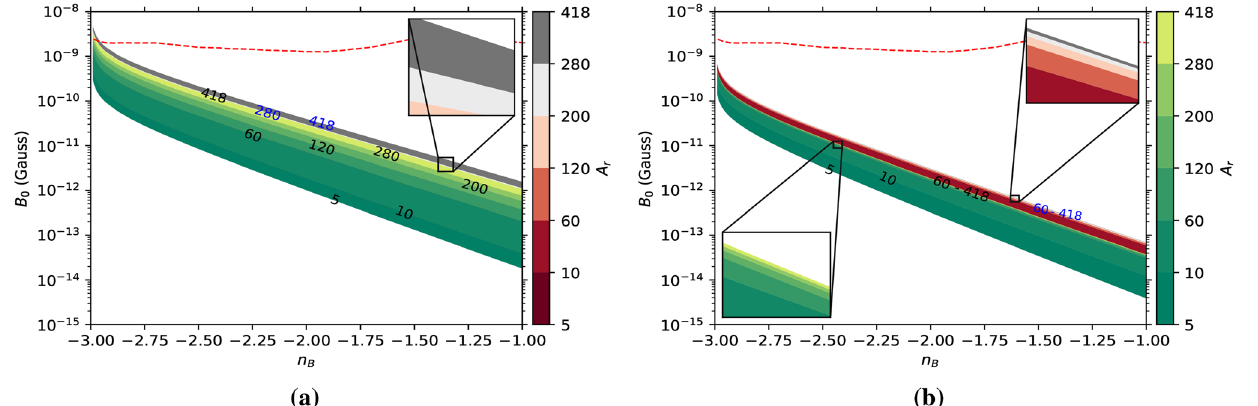
Fig. 4 In these plots, we study upper bounds on the present-day mag- with black coloured text. In plot a , we consider T S (cid:10) T gas and do not netic field strength ( B 0 ) with spectral index ( n B ) for different val- take into account the X-ray and VDKZ18 effects. While in figure b , we consider the effects of VDKZ18 and X-ray on IGM gas due to first ues of excess radiation fraction ( A r ) . The green-yellow and red-grey stars after z (cid:2) 35 and consider finite Ly α coupling. The colour-bars are colour schemes represent the cases when T 21 | z = 17 . 2 (cid:10) − 500 mK and − 300 mK, respectively. For T | (cid:10) − 300 mK case the value of common for both plots. The red dashed line depicts the Planck 2015 z = 17 . 2 21 n B writtenwithbluecolouredtext,whilefor − 500 mKcaseitiswritten upper constraint on the present-day magnetic field strength